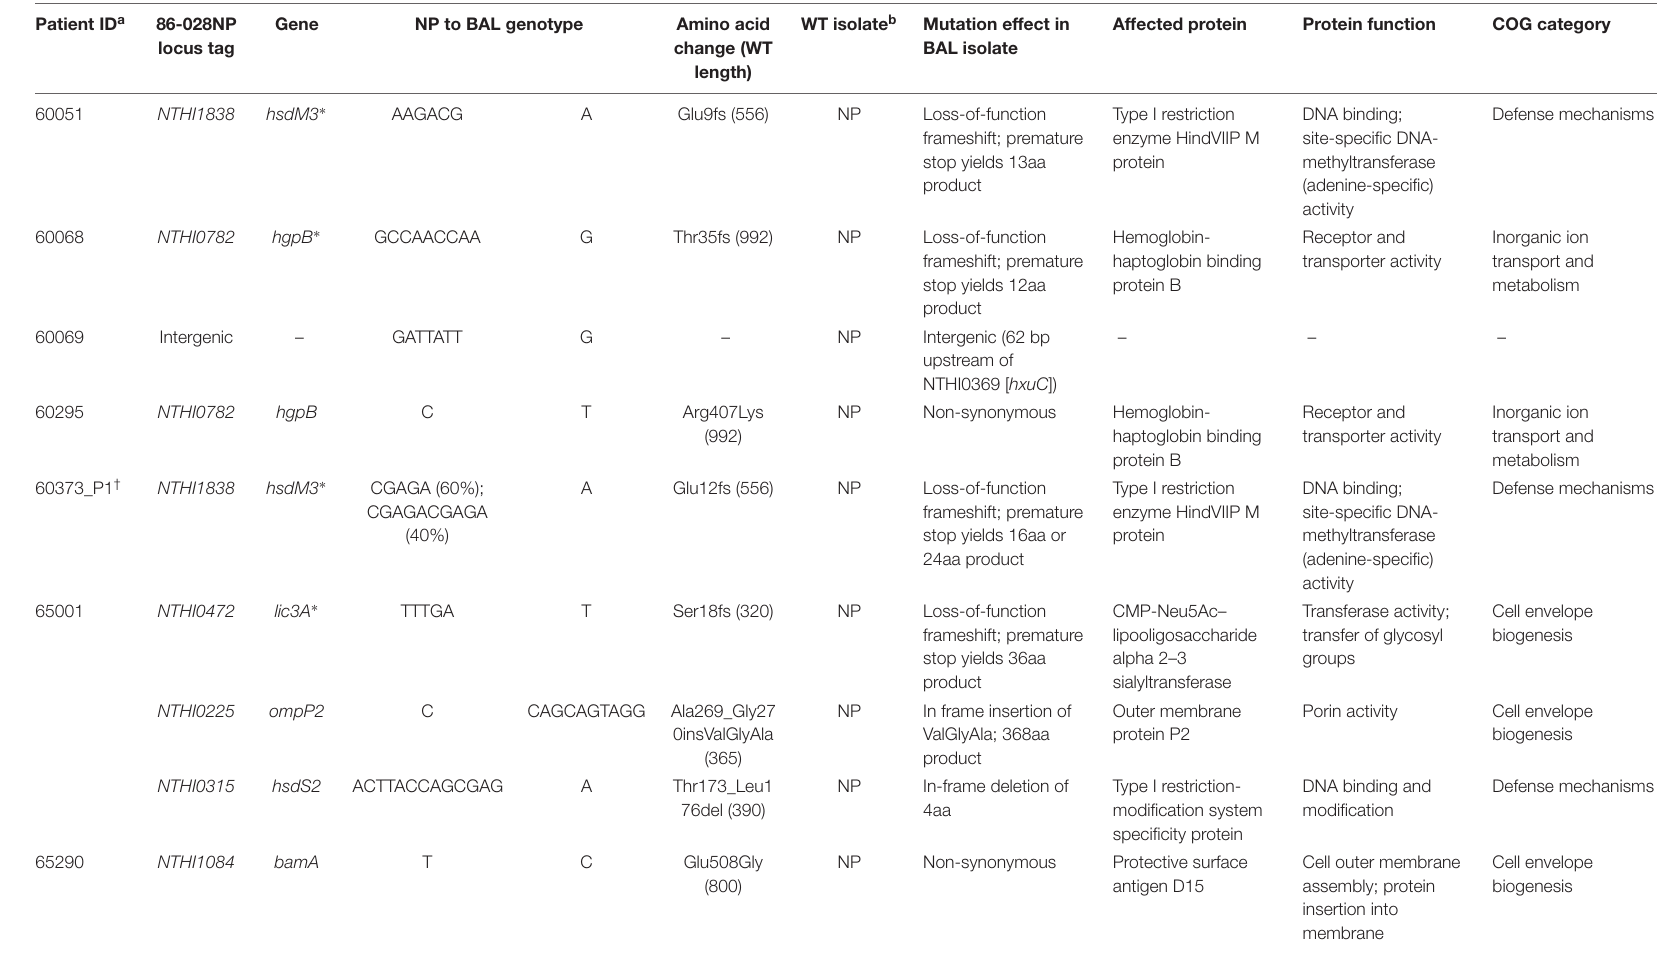
TABLE 2 | Summary of genetic variants identified between 12 paired, isogenic non-typeable Haemophilus influenzae isolates retrieved from the nasopharynx vs. lower airways (bronchoalveolar lavage;